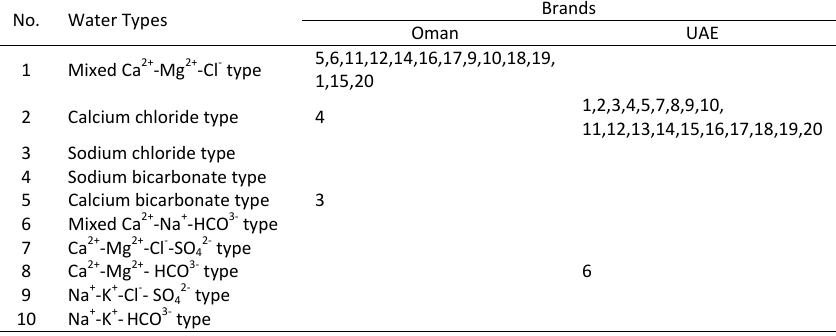
Table 3: Classification of Omani and UAE bottled brands based on piper diagram